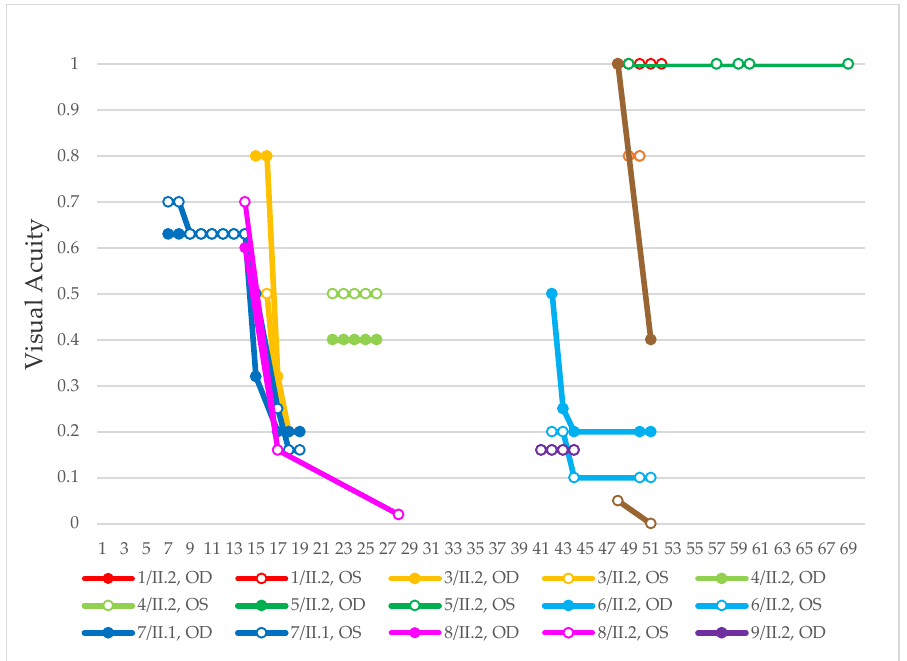
Figure 2. Evolution of the visual acuity in patients harboring pathogenic bi-allelic ABCA4 variants. Best corrected visual acuity was assessed at indicated age (years), each dot indicating a clinical examination. OD, right eye; OS, left eye. Patient descriptions in text and tables.